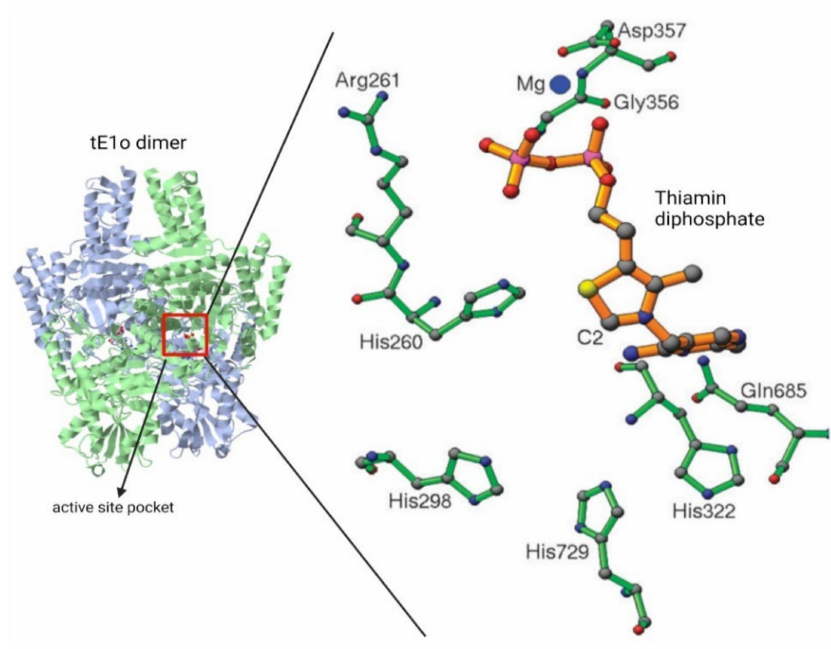
Figure 3. The E. coli E1o active site showing His260, His 298 and His 729 suggested to interact with the distal carboxylate of 2-OG (PDB: 2JGD) [39]. The ThDP coordinates were added by